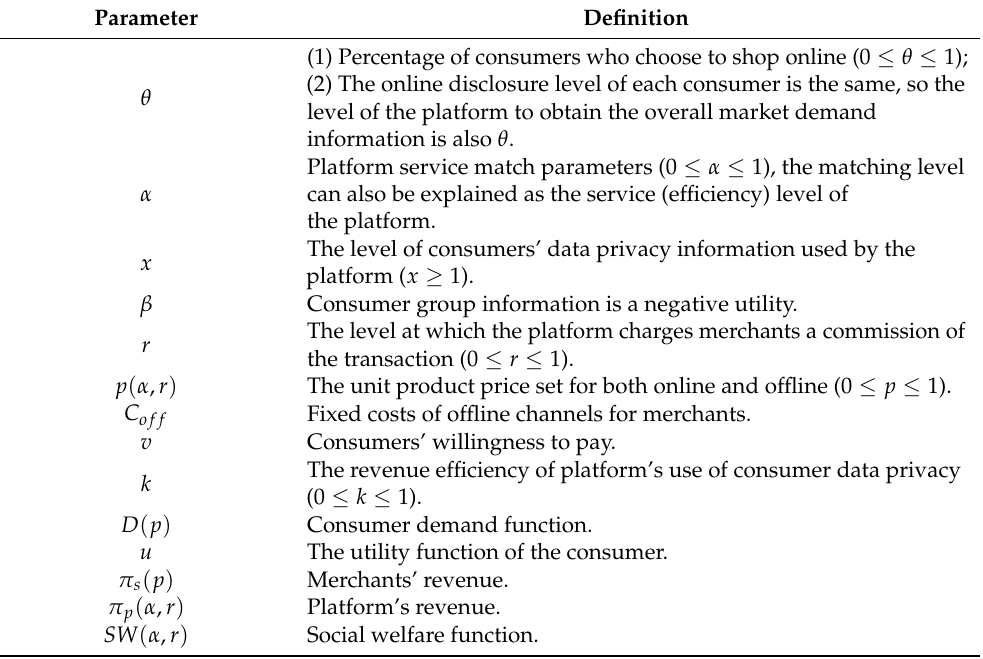
Table 1. Parameter